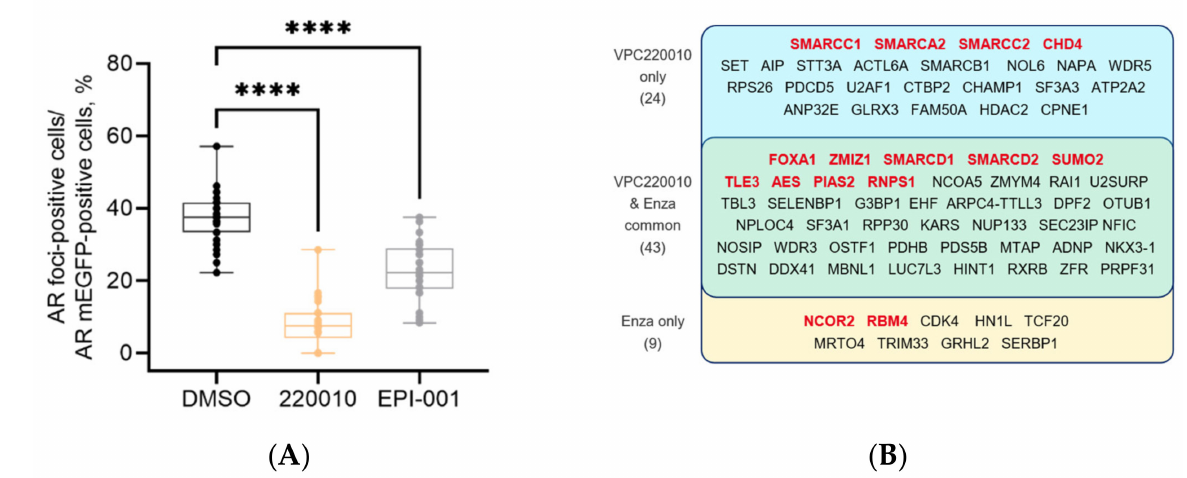
Figure 6. VPC-220010 impacts the formation of phase condensates and recruitment of co-regulatory protein ( A ) Effect of 10 µ M VPC-220010 or EPI-001 on foci formation in AR-mEGFP transfected LNCaP cells. Condensates were quantified by using confocal microscopy. The dotted blot presents the data from at least 30 cells from three independent experiments. p values are indicated by stars: **** < 0.0001. ( B ) RIME results of LNCaP cells treated with EtOH, DHT, VPC-220010 or ENZA. The co-regulatory proteins inhibited by treatment of both VPC-220010 and ENZA or each individual compound are listed above. Genes highlighted in red have been previously identified as AR interacting